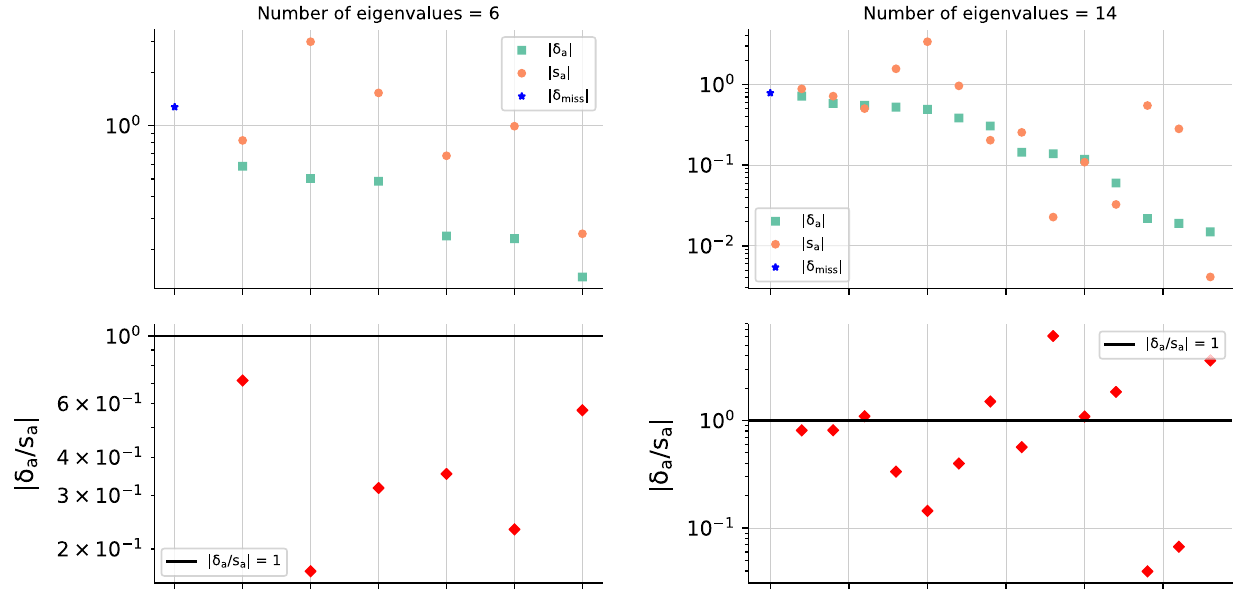
Fig. 13 Same as Fig. 12 but for the asymmetric prescriptions: 3-point (left) and 7-point (right)